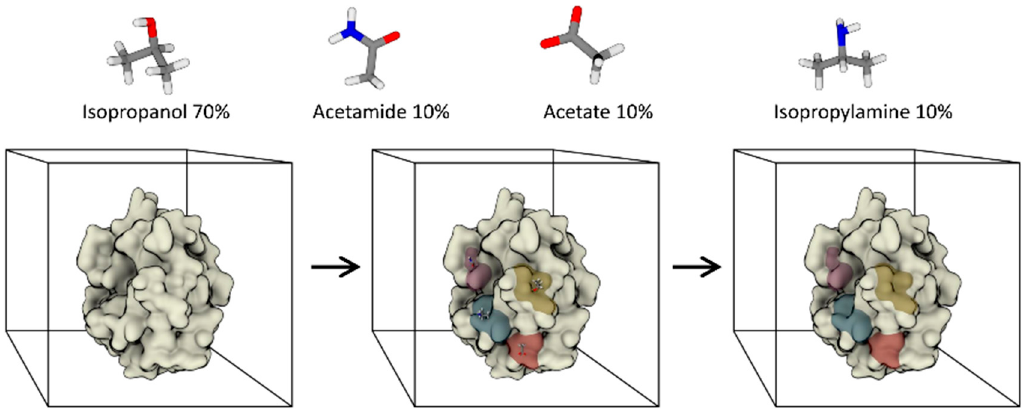
Figure 2. Schematic representation of hot-spots identified through solvent mapping approaches. The displayed co-solvent mixture is taken from [54].